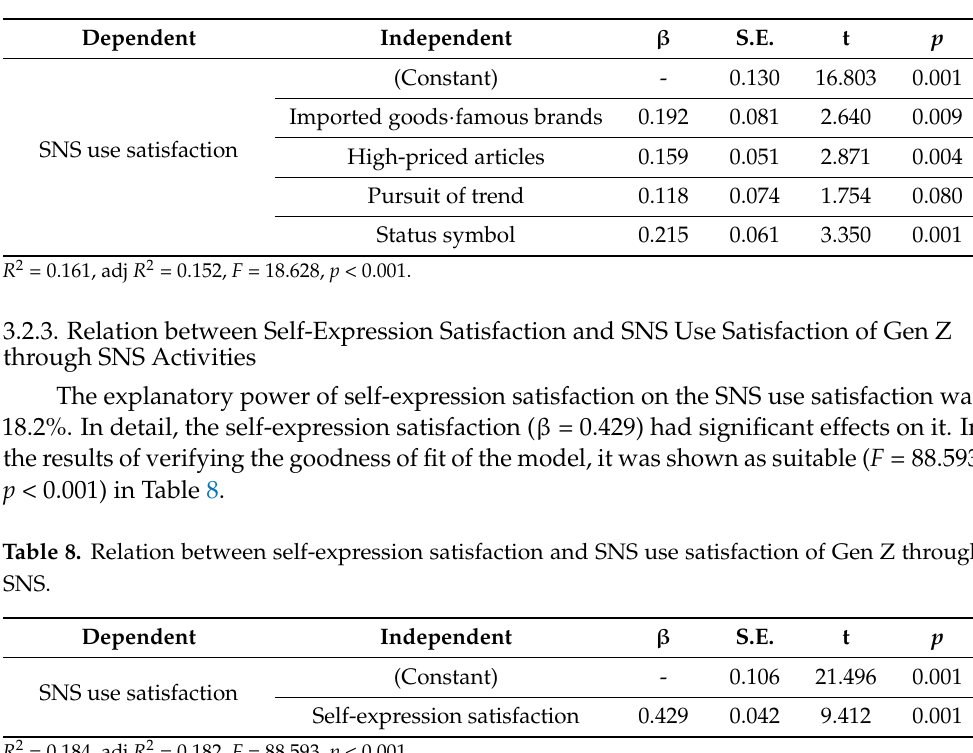
Table 7. Relation between conspicuous consumption tendency and SNS use satisfaction of Gen Z through SNS activities.